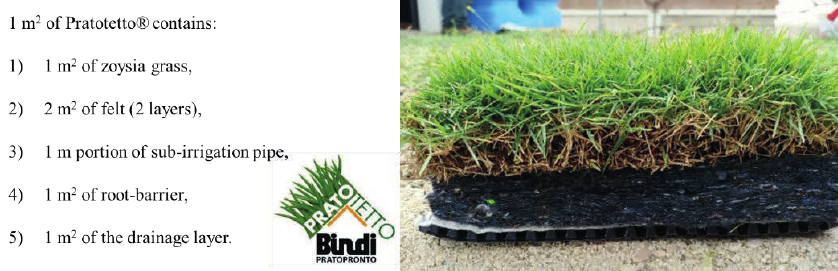
Fig. 1. Pratotetto ® stratigraphy (excepting irrigation pipes) and